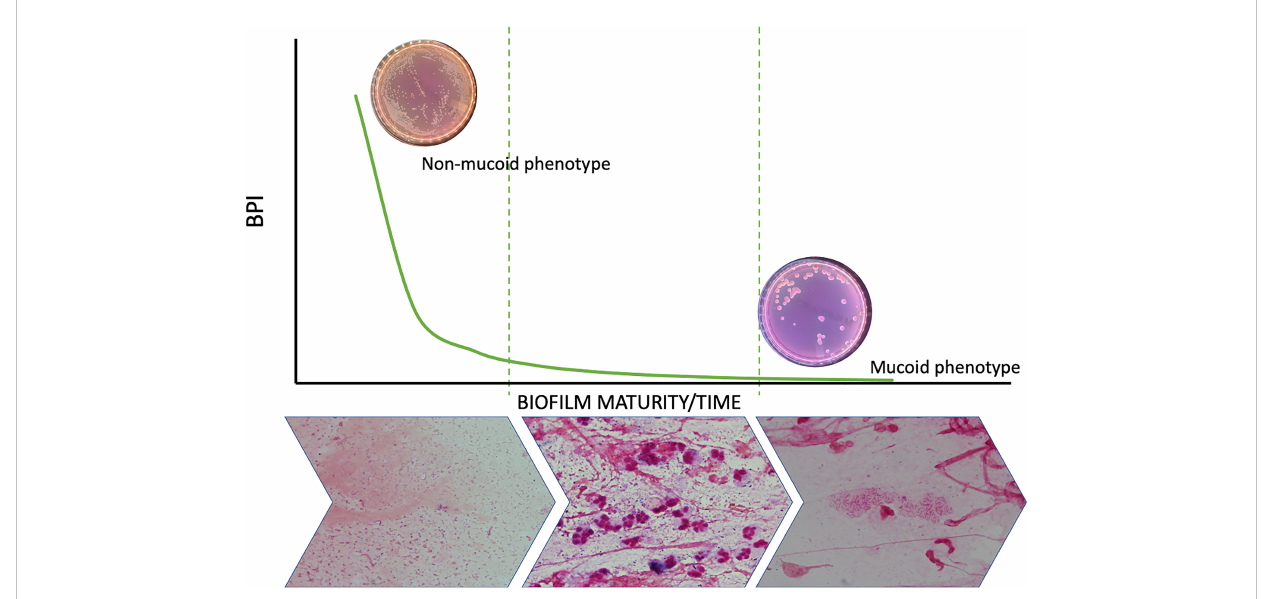
FIGURE 6 Bio fi lm dynamic during time and phenotype switch. The fi gure shows how the metabolic ratio of PA decreases whilst phenotype switches from a non-mucoid state to a mucoid phenotype and at the same time PA starts growing in bio fi lms instead of being found in planktonic state.